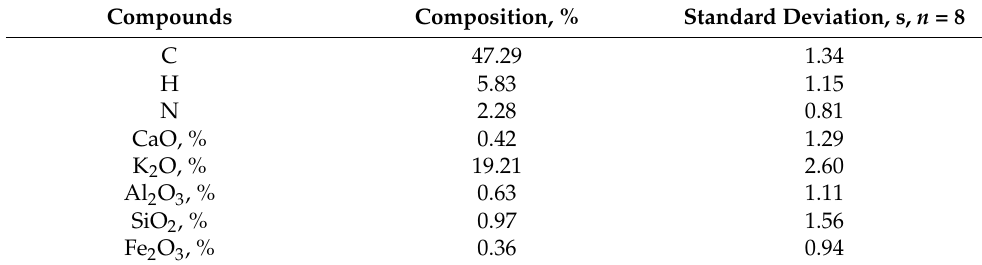
Table 6. Chemical composition of production potassium humate.